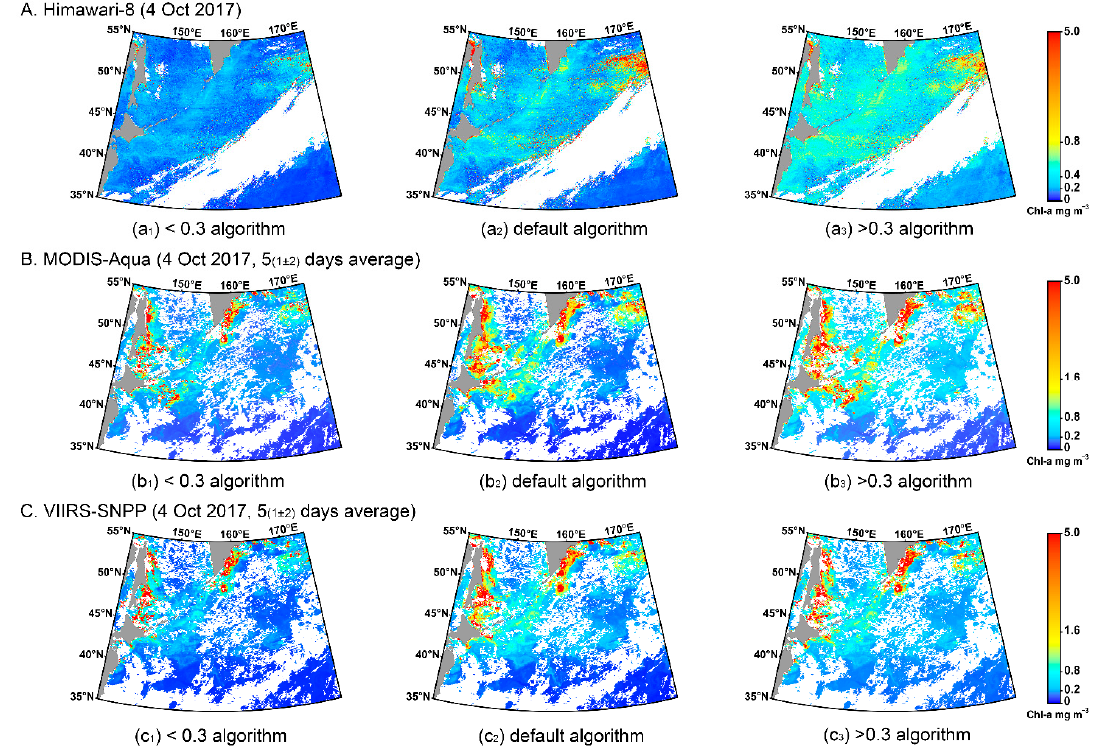
Figure 7. Sample satellite images. ( a 1 – a 3 ) are Himawari-8 Chl-a data; ( b 1 – b 3 ) are MODIS-Aqua Chl-